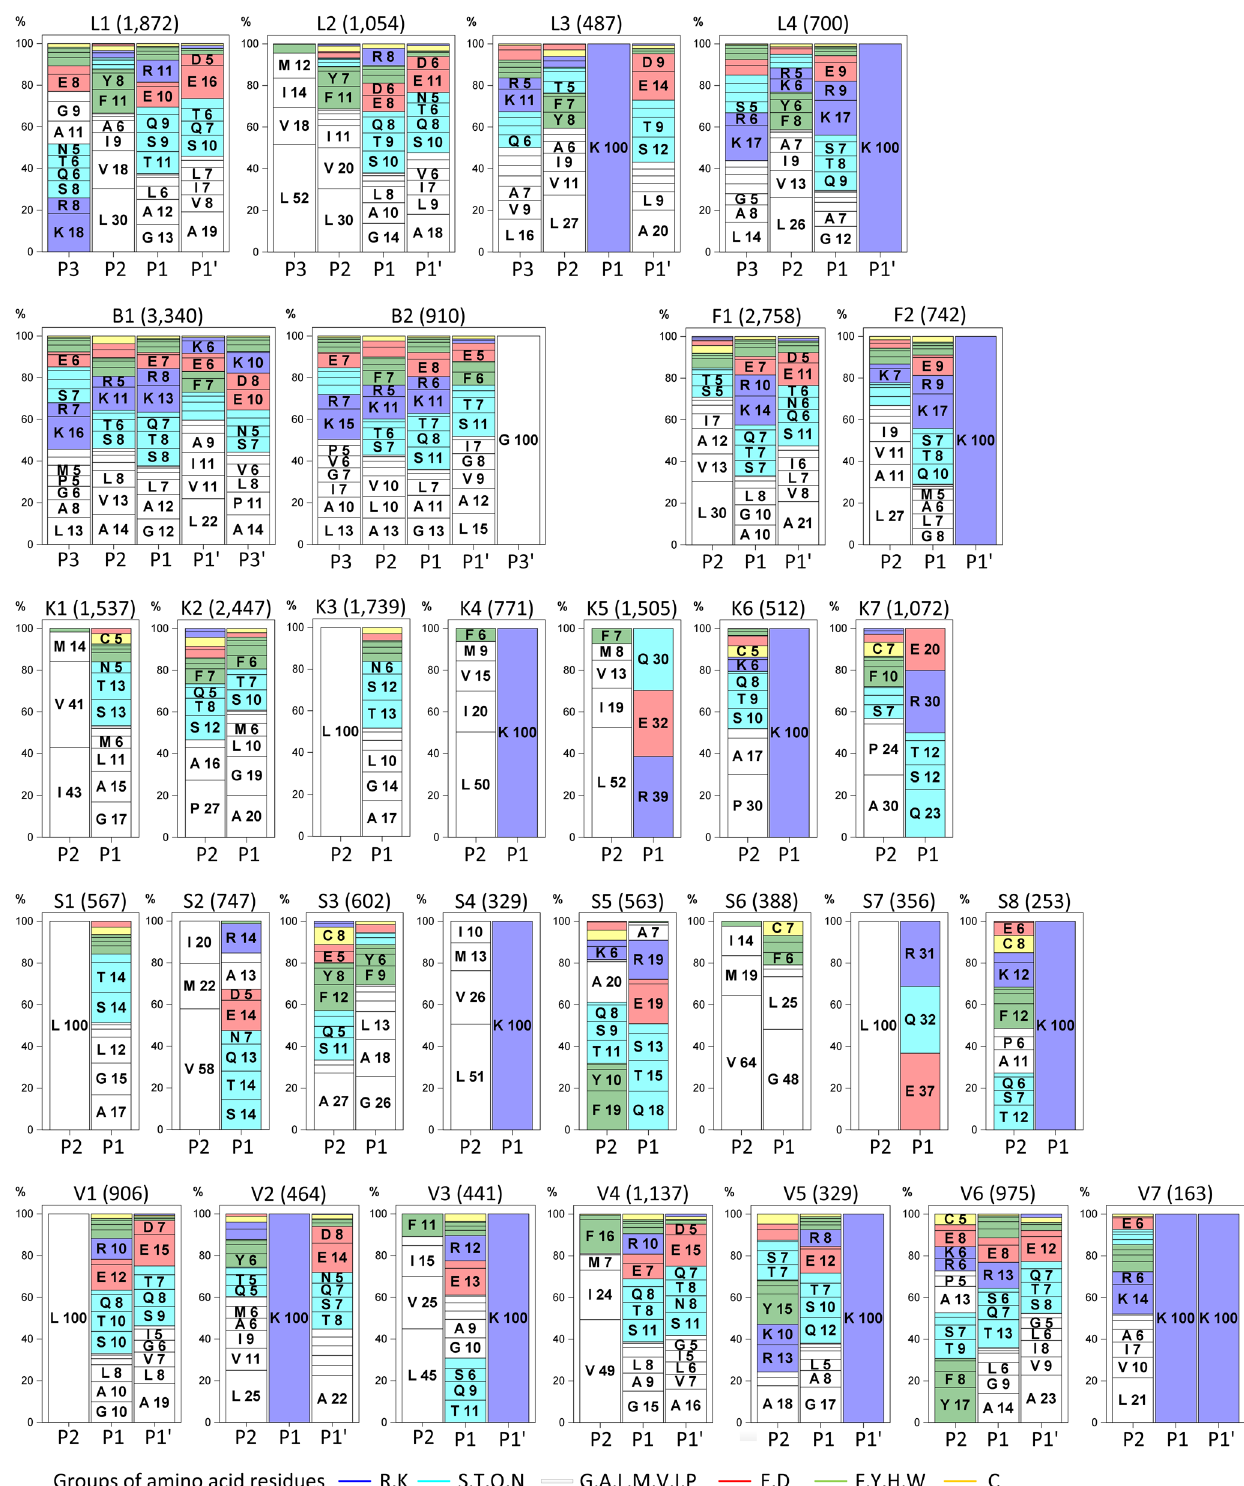
Fig. 3 Relevant clusters of substrate speci fi city. Each frame describes one cluster. The cathepsin identi fi er, cluster number and the number of the peptides in a cluster are indicated on top of each fi gure. The blocks of residues are sorted according to their share and the background color represents the chemical type of the amino acid